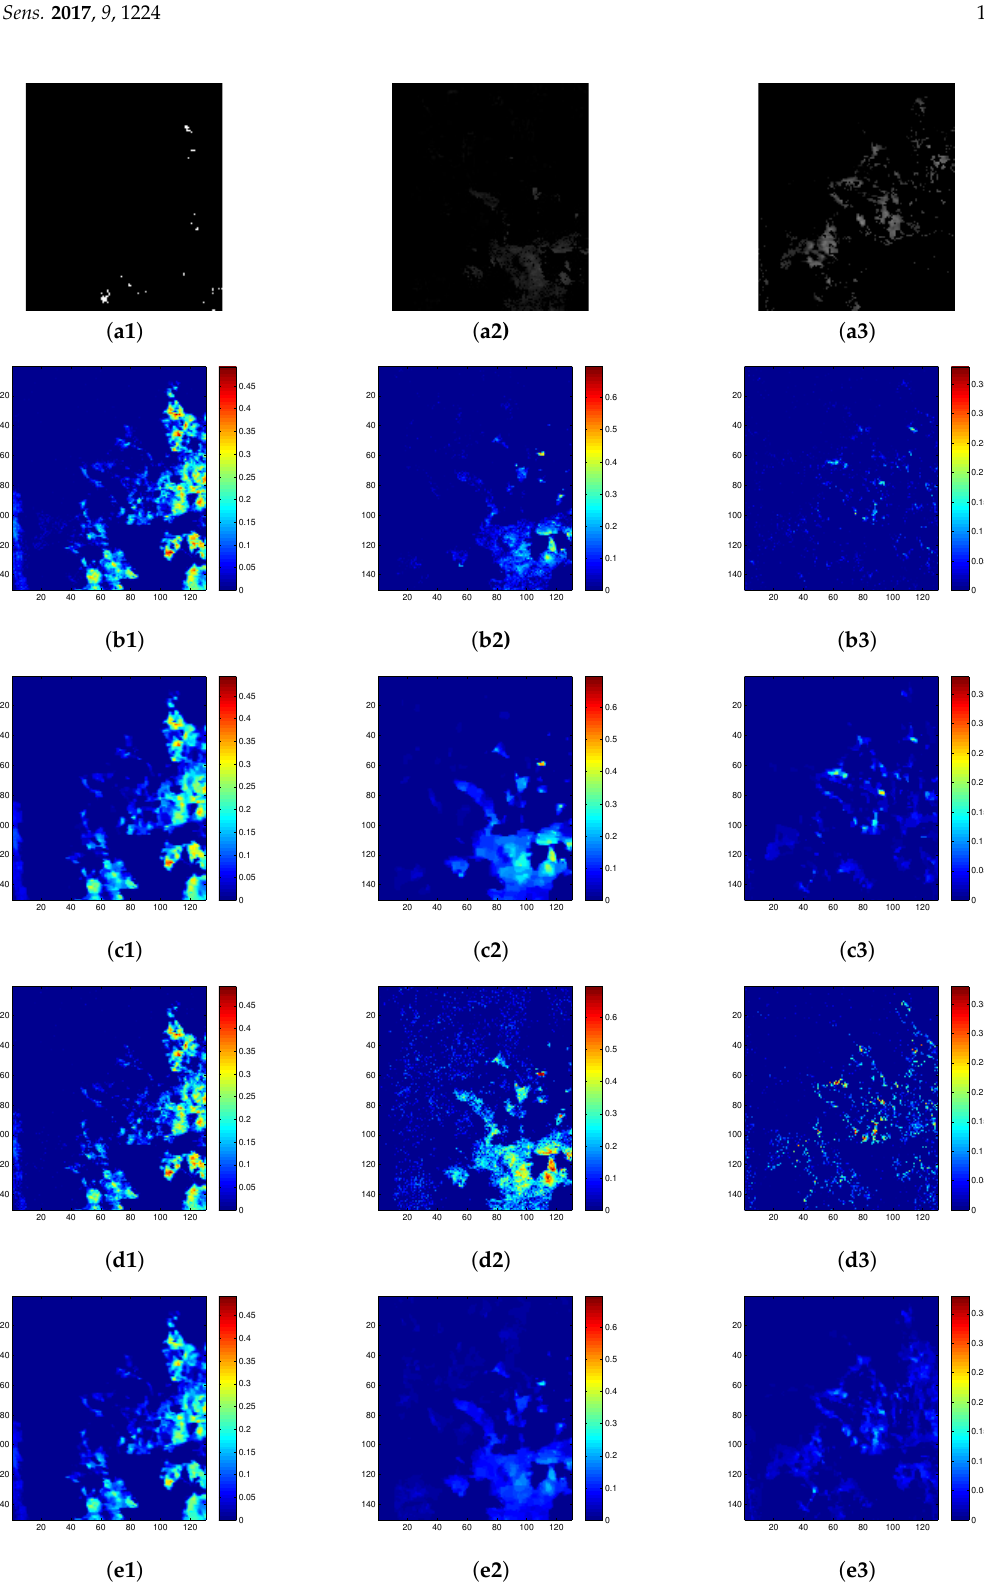
Figure 9. Estimated abundance maps of Cuprite data subscene for endmember alunite, chalcedony , and kaolinite (column 1 – 3 ) using CLSUnSAL, SUnSAL-TV, ADSpLRU and J-LASU (row b – e ). First row ( a ) shows classification maps of endmembers from USGS